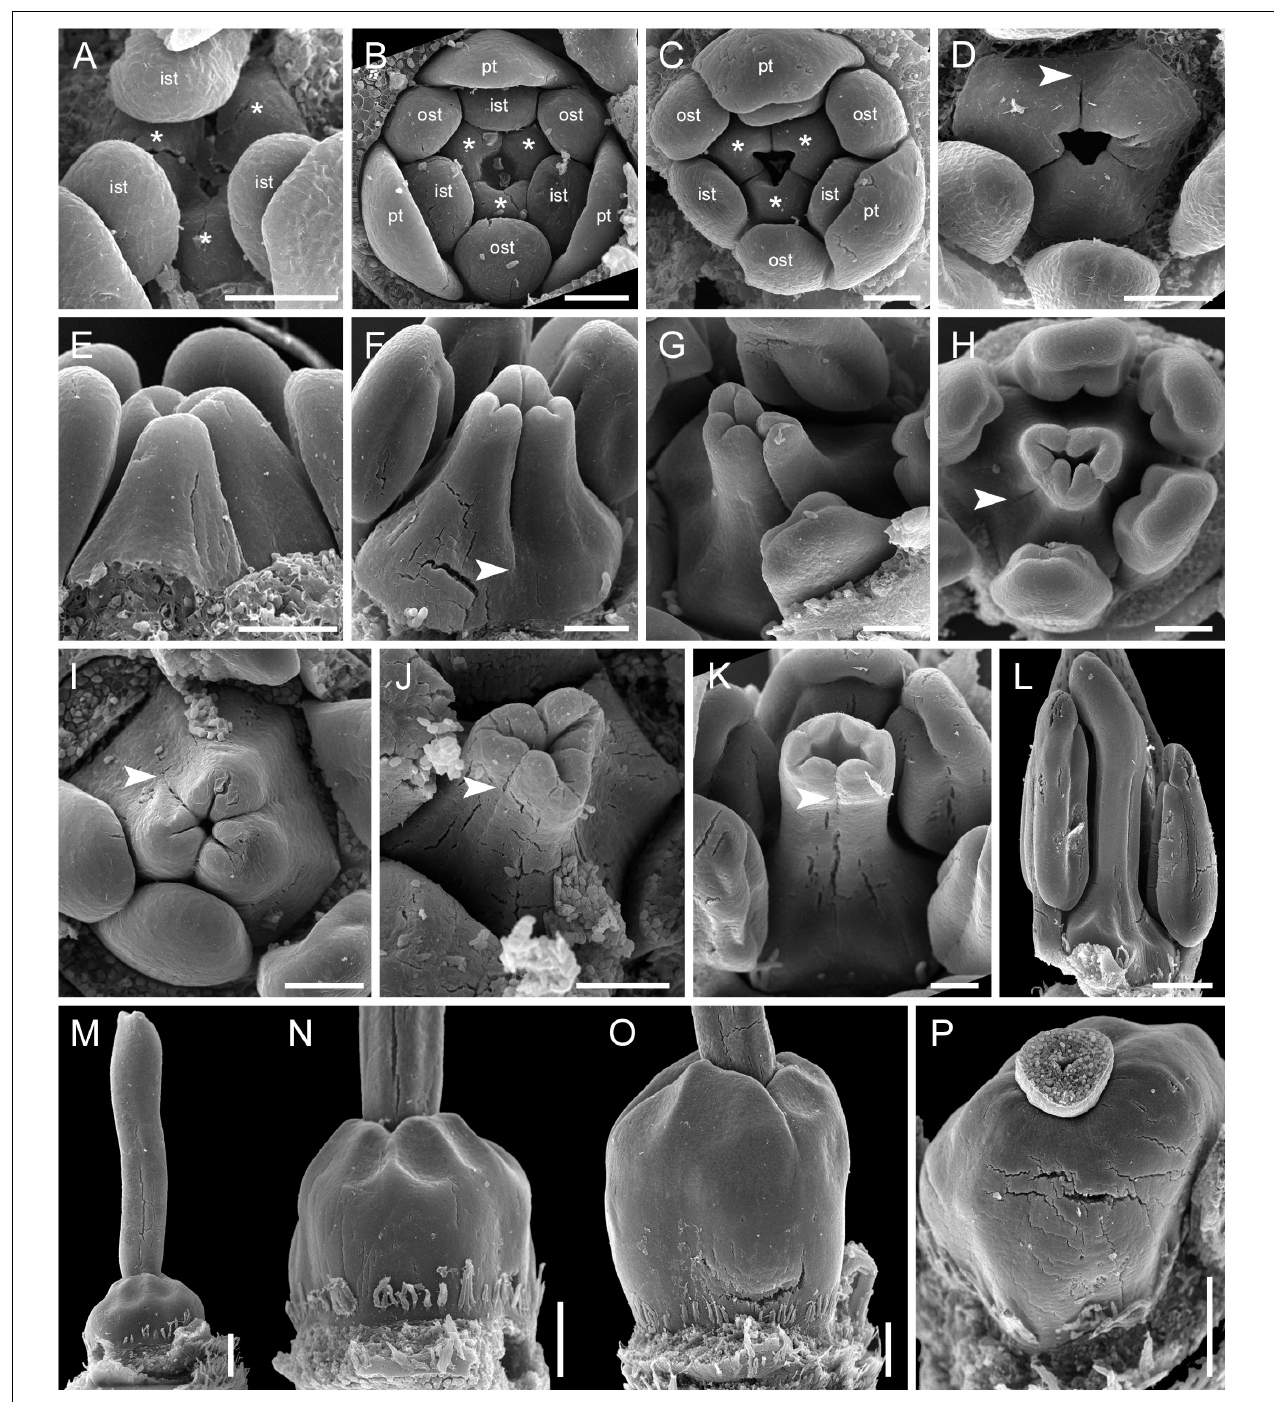
FIGURE 10 | Flower development in Rapateoideae. Duckea junciformis , gynoecium development. (A) Gynoecium initiation as three separate carpel primordia. (B) Very young plicate carpels are united via zonal growth. (C,D) Gynoecium with prominent asymplicate zone. Elongation of free plicate carpel parts (asymplicate zone); surrounding organs removed in panel (D) to show gynoecium base. (E–G) Gynoecium with prominent asymplicate zone. Further elongation of free plicate carpel parts (asymplicate zone). (H) Gynoecium with prominent asymplicate zone. Beginning of postgenital fusion between the carpels. Lines of postgenital fusion are clearly visible. (I) Gynoecium with short asymplicate zone. Stage similar to panel (E) . (J,K) Boundaries between the carpels are still tracable. Ovary becomes separated from the style. Style tip showing stylar canal in panel (K) . (L) Lines of postgenital fusion are no longer visible starting from this stage. (M–O) Progressive stages of ovary elongation. (P) Mature ovary with style removed to show stylar canal. *, carpels; ist, inner stamen; ost, outer stamens; pt, petals. Arrowheads show visible boundaries of postgenital fusion in asymplicate zone. Scale bars = 100 mm in panels (A–K) and 300 mkm in panels (L–P) .